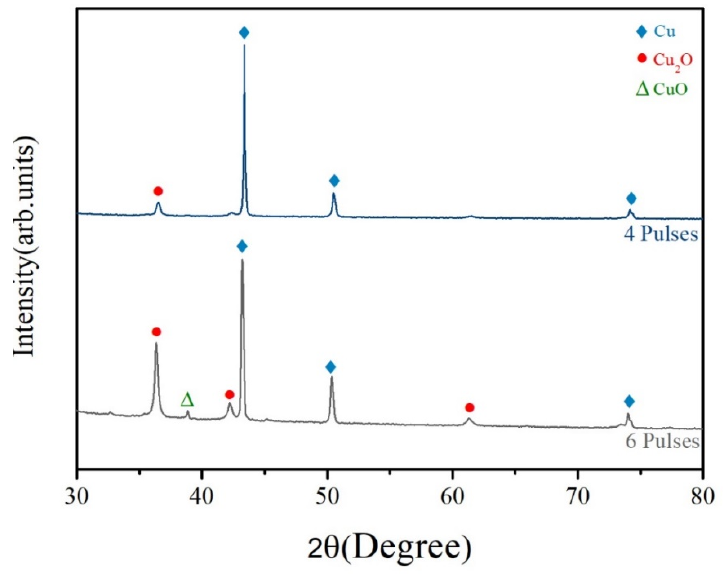
Figure 8. XRD results for hybrid copper pastes that contain copper formate following flash pulses.